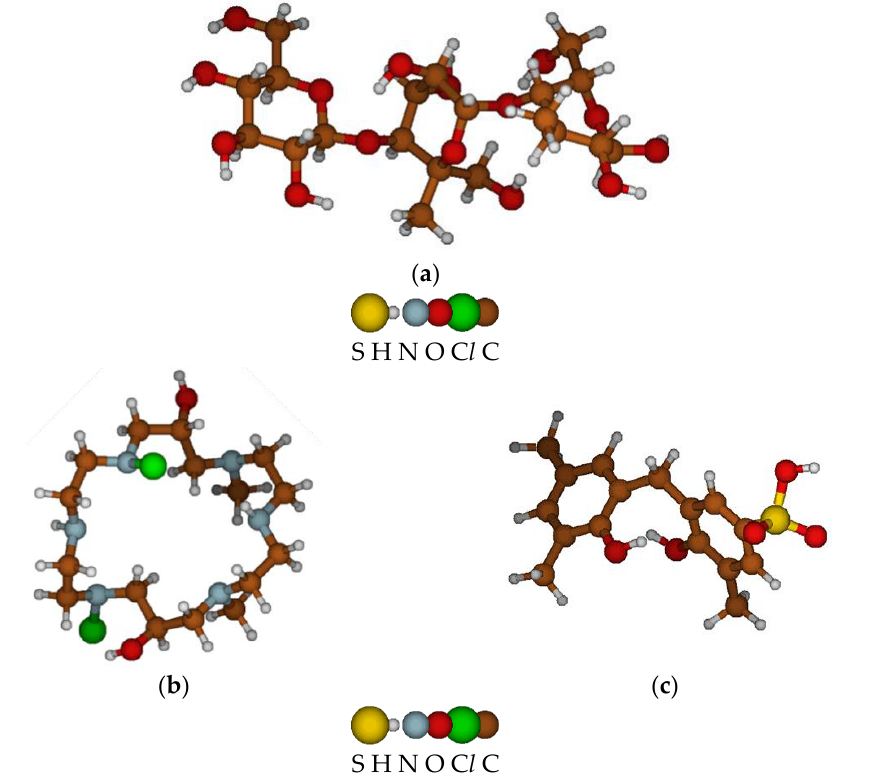
Figure 4. Elementary optimized fragments of viscose nonwoven fabric ( a ), anionite ( b ), and cationite ( c ) matrices.